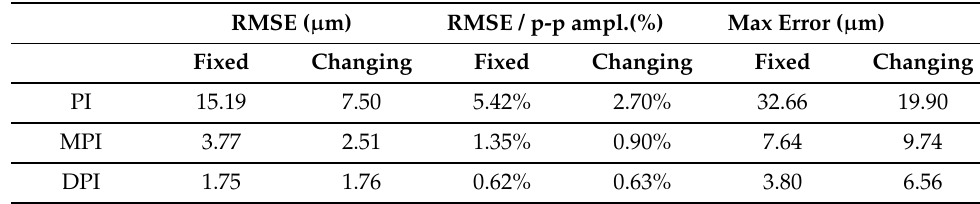
Figure 7. Compensation results at changing amplitudes sinusoidal wave using the PI, MPI and the DPI model, respectively. ( a ) Compensation results at changing amplitudes using the PI model. ( b ) Compensation results at changing amplitudes using the MPI model. ( c ) Compensation results at changing amplitudes using the DPI model. Table 2. Compensation experimental